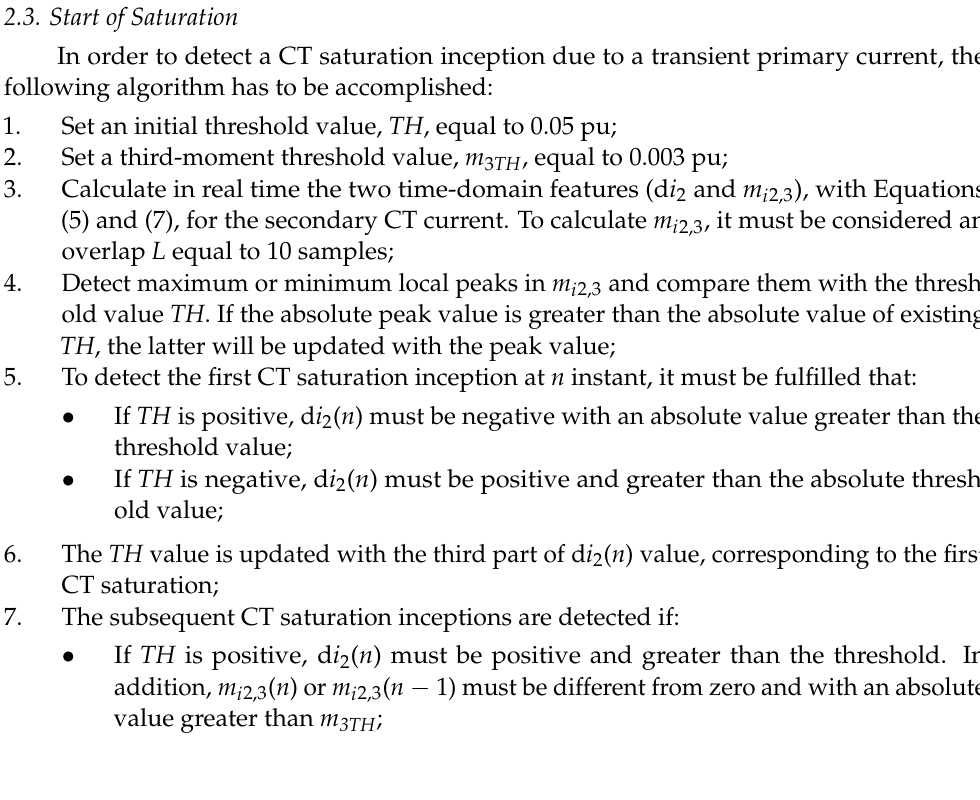
Figure 4. Moving third-order central moment ( m i 2,3 ) of a saturated inrush current ( i 2 ), and an enlargement of both signals during the first two saturation intervals.